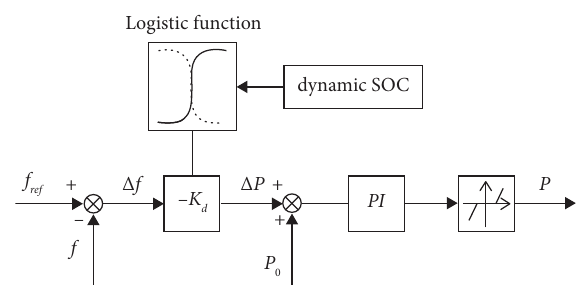
Figure 1: Improved droop control based on logistic